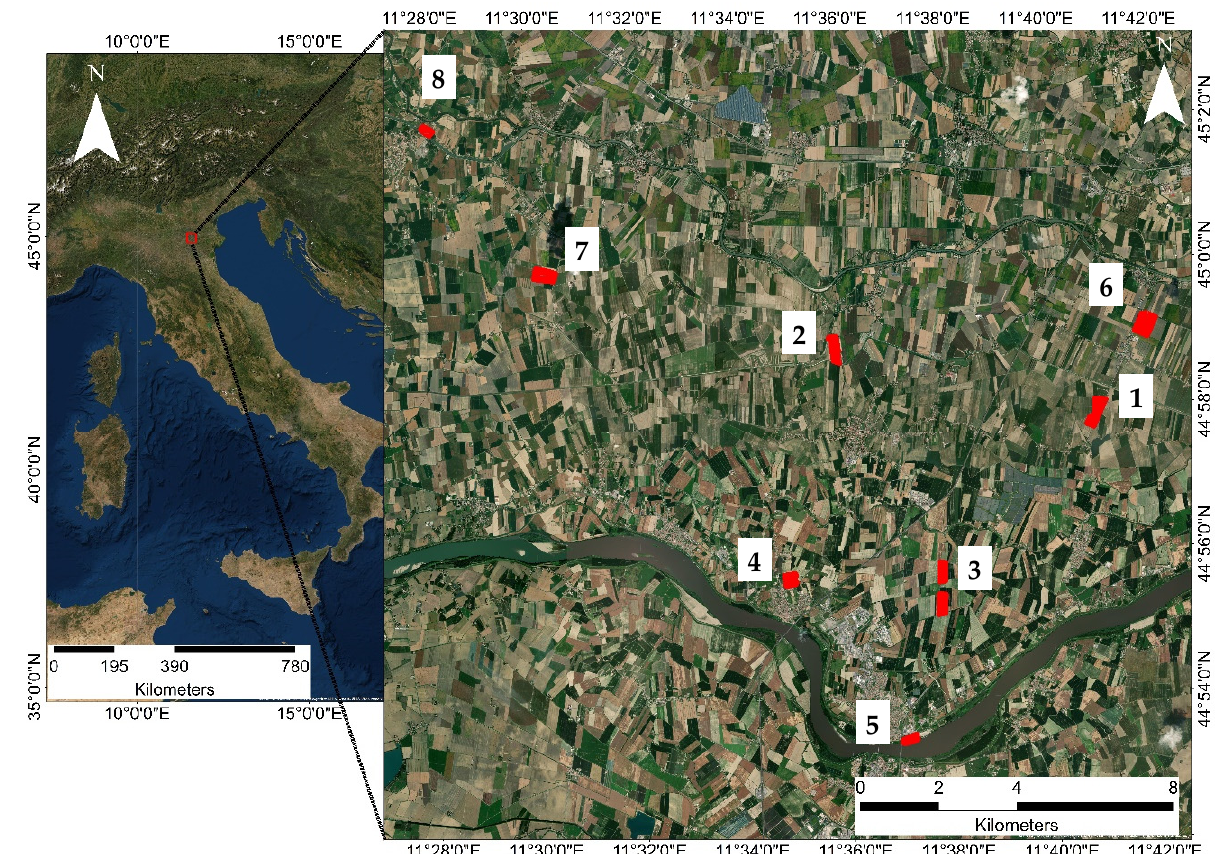
Figure 1. Aerial image of the study fields (Esri, 2019) with numbers indicating the different experimental areas discussed in Table 1. Table 1. Planting, Fertilization, Irrigation and Harvest dates for all the study fields. Damaged fields are labeled as D, whereas not damaged fields are marked as ND. * Irrigation events are expressed as total irrigation events and water volumes (in m 3